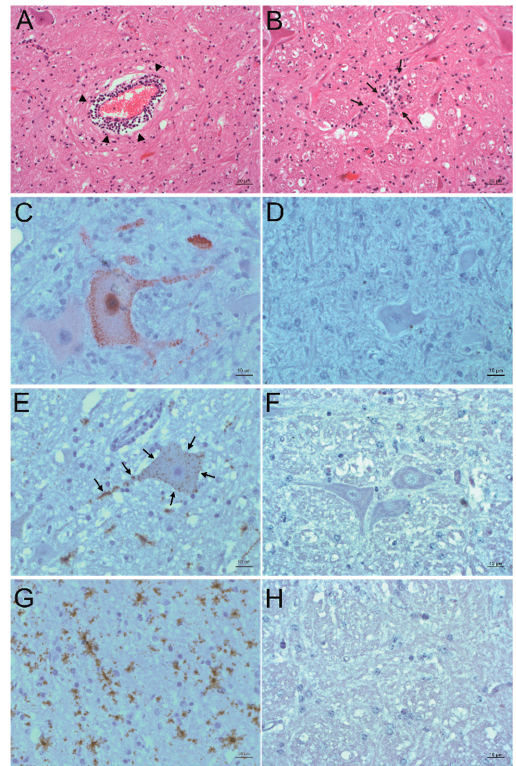
Figure 3. Detection of PIV5 antigen and RNA and their association to sites of inflammation. A, B: Histopathological analysis. Hematoxylin and eosin (H&E) staining of the formatio reticularis of animal 26731. Signs of non-suppurative encephalitis are present as perivascular cuffs ( A , arrowheads) and glial nodes ( B , arrows). C, D: Detection of viral antigen by immunohistochemistry (IHC) using the antibody PIV5 V5 TAG clone 2F11F7. In the formatio reticularis of animal 26731 ( C ), PIV5 antigen (red) can be seen in neurons, whereas in negative control animal 31292 ( D ), no PIV5 antigen can be detected. E, F: Detection of viral RNA by in situ hybridization (ISH) using the PIV5 RNAscope probe. In the formatio reticularis of animal 26731 ( E ), PIV5 RNA (arrows, brown) can be seen in neurons, whereas in negative control animal 31292 ( F ), no PIV5 RNA can be detected. ( G , H ) Detection of viral RNA with ISH using the PIV5 RNAscope probe. In the rhinal cortex of animal 26731 ( G ), PIV5 RNA (brown) shows no clear association to a specific cell type. In negative control animal 31292 ( H ), no PIV5 RNA can be detected. The scale bars at the bottom of the microphotographs correspond to 20 µ m ( A , B , G ), and 10 µ m ( C – F , H ),